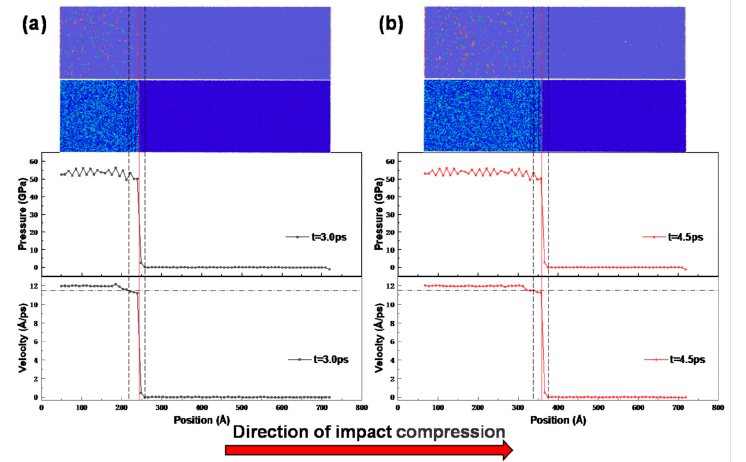
Figure 9. Cross-sectional view of atomic structure, energy propagation, stress, and particle velocity of non-porous NiTi samples after impact compression: ( a ) 3.0 ps; ( b ) 4.5 ps (the black chain line marks the position of 95% maximum velocity, the black dotted line marks the position of the shock wave front, and the red line indicates the elastic–plastic transition